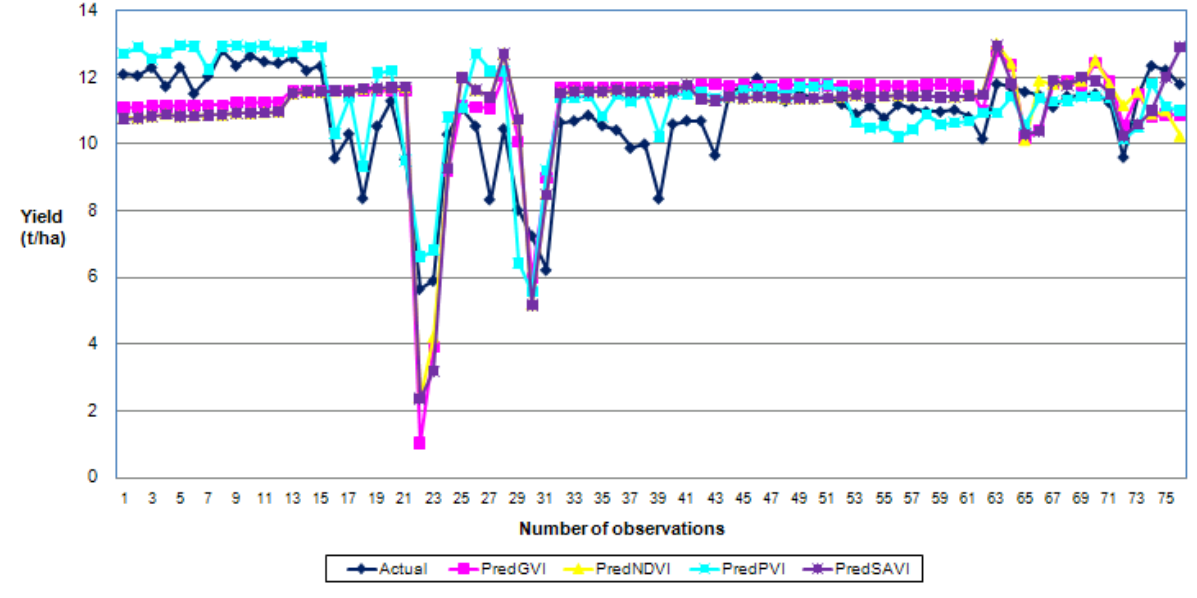
Figure 12. Comparison of VI-NN model prediction ability for pool